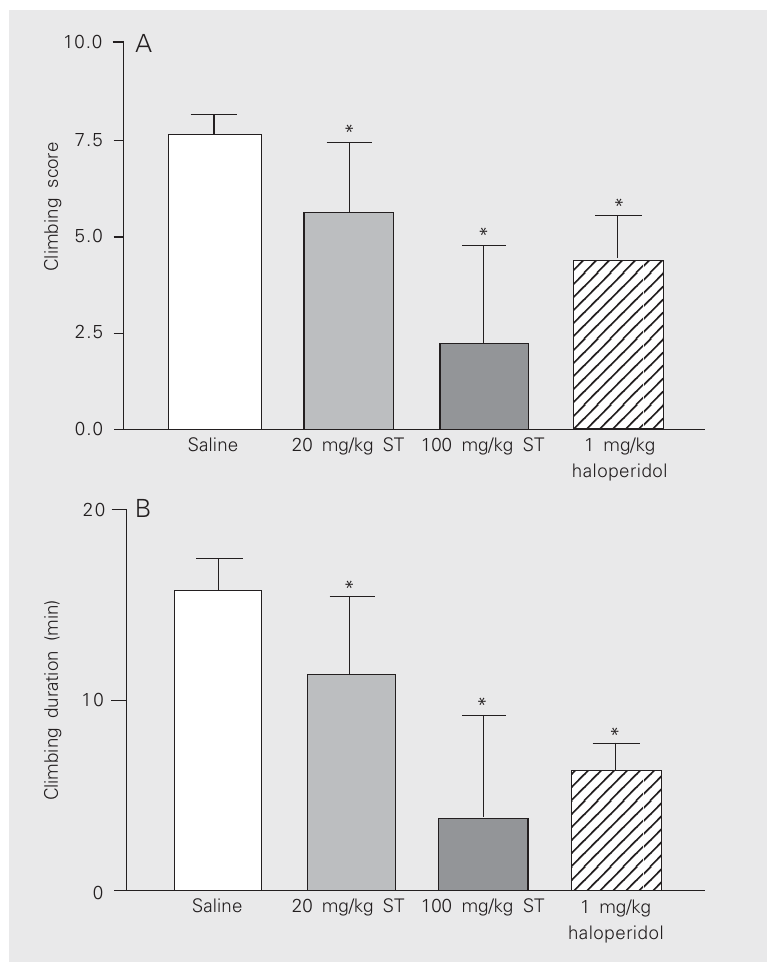
Figure 3. Effect of Sapindus trifoliatus extract at 20 and 100 mg/kg, ip , and haloperidol (1 mg/kg, ip ) on climbing behavior induced by apomorphine (2.5 mg/kg, ip ). Each column indicates the mean ± SEM of the total climbing score for groups of 10 mice. A , Climbing score was assessed at 5-min intervals for 20 min, starting 10 min after apomorphine administration. A score of 10 is the maximum possible. B , Total time (min) spent climbing on the cage wall for 20 min, starting 10 min after apomorphine administration. *P < 0.05 compared with saline-treated animals (ANOVA followed by Dunnetts’